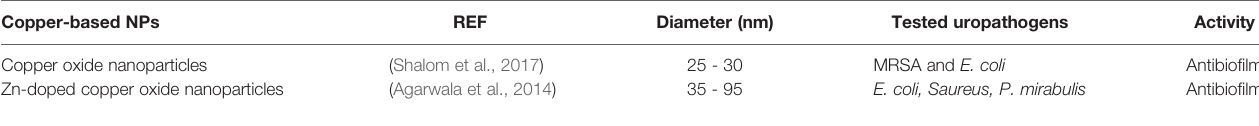
TABLE 5 | Physical characteristics of copper-based